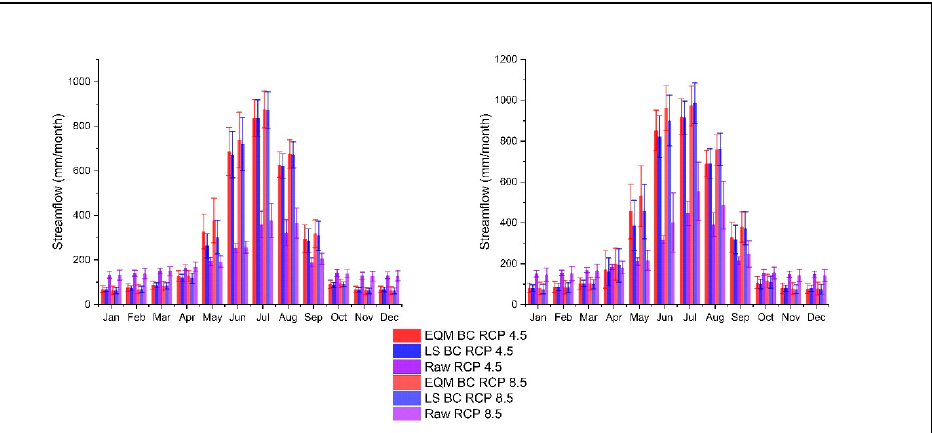
Figure 9. As Figure 8, but for 10th percentile ( left ) and 90th percentile ( right ) streamflow over the period 2040–2069.